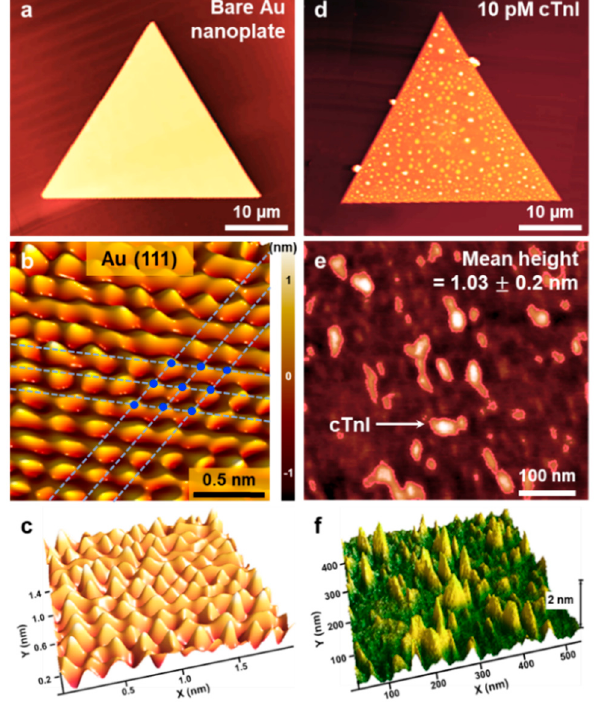
Figure 2. ( a ) Atomic force microscopy (AFM) topography image of a bare Au nanoplate. ( b ) Fourier bandpass-filtered atomic stick-slip image showing a well-defined Au (111) surface. ( c ) Three-dimensional Fourier bandpass-filtered atomic stick-slip image of the Au (111) surface. ( d ) AFM topography image of an aptamer-immobilized Au nanoplate after reaction with cTnI (10 pM). ( e ) Magnified and ( f ) three-dimensional AFM images of a cTnI-captured Au nanoplate.